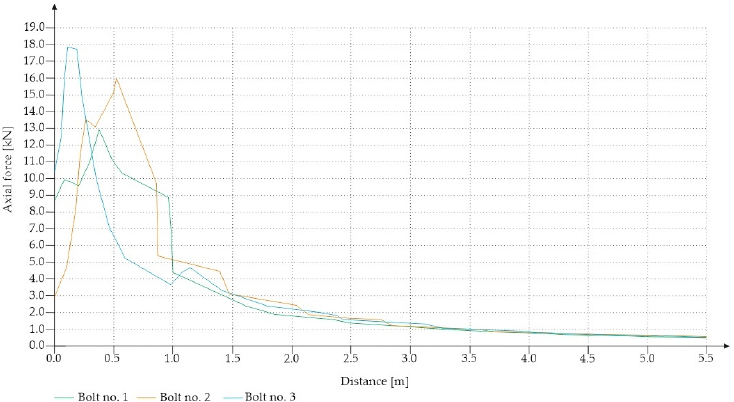
Figure 9. Total strain for Vernier excavation with full-length anchor bolting (Hoek–Brown